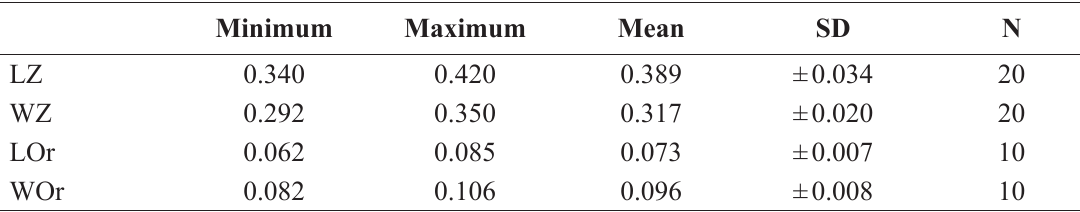
Table 8. Measurements in mm of Micropora vredenburgi Guha & Gopikrishna, 2005 (GIS/B 0516 to 0521), Burdigalian, lower Miocene, Chhasra Formation, western Kachchh, Gujarat, India. Abbreviations: see Material and